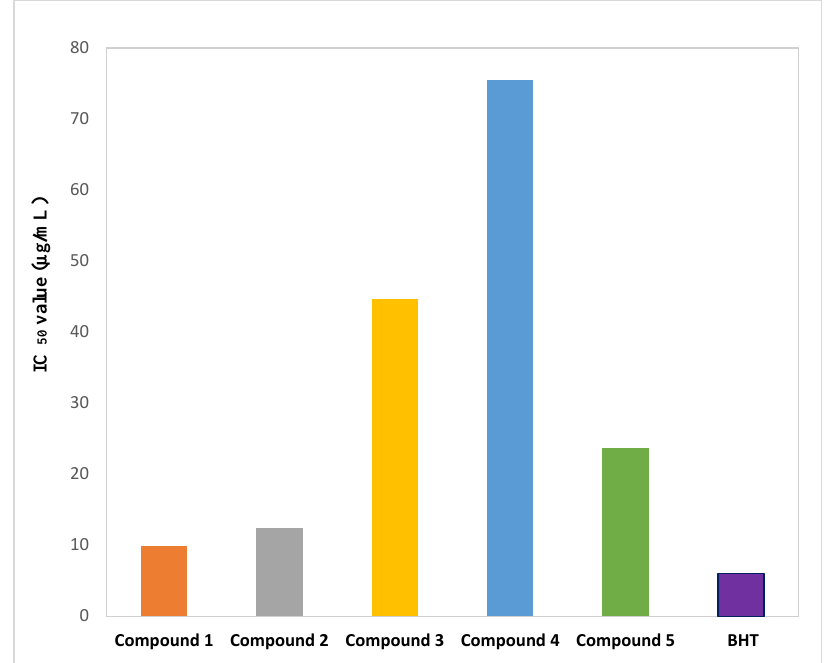
Figure 3. IC 50 values of Butylated Hydroxytoluene (BHT) and isolated phytochemicals of Glycosmis cyanocarpa .